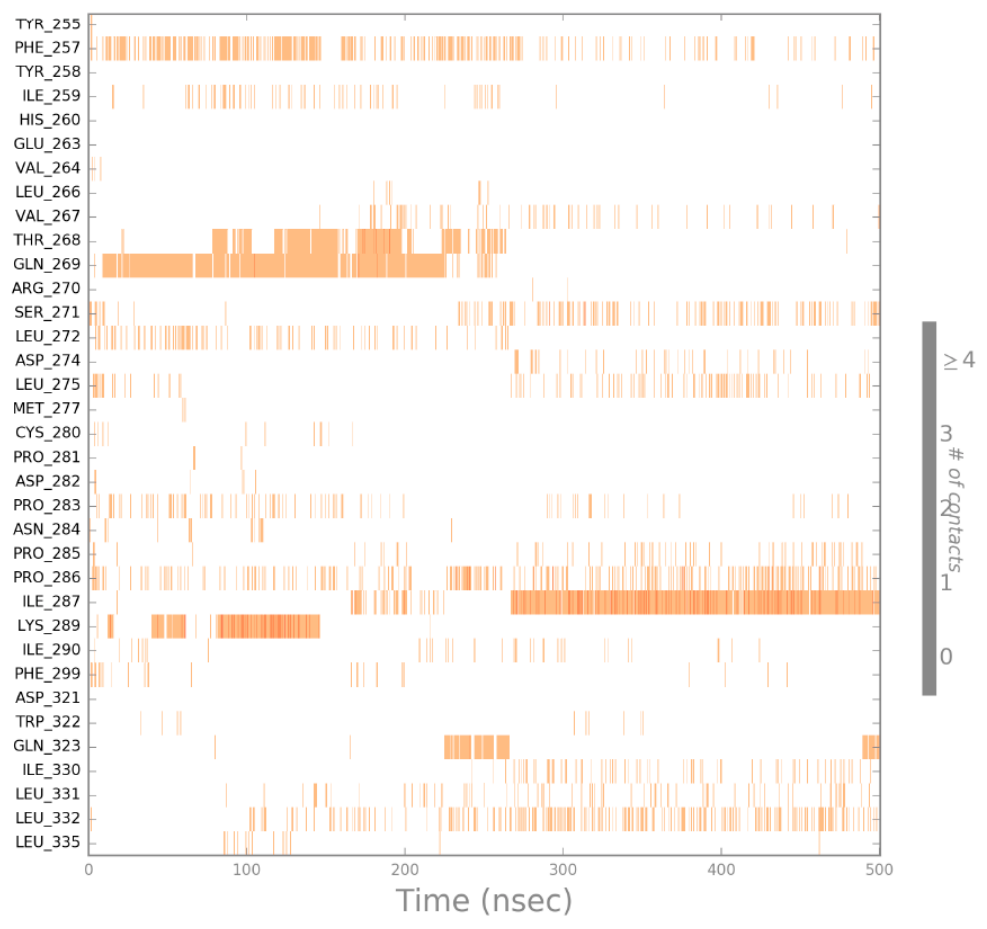
Figure 8. Protein–ligand contact timeline. Darker shades correspond to a higher number of contacts.